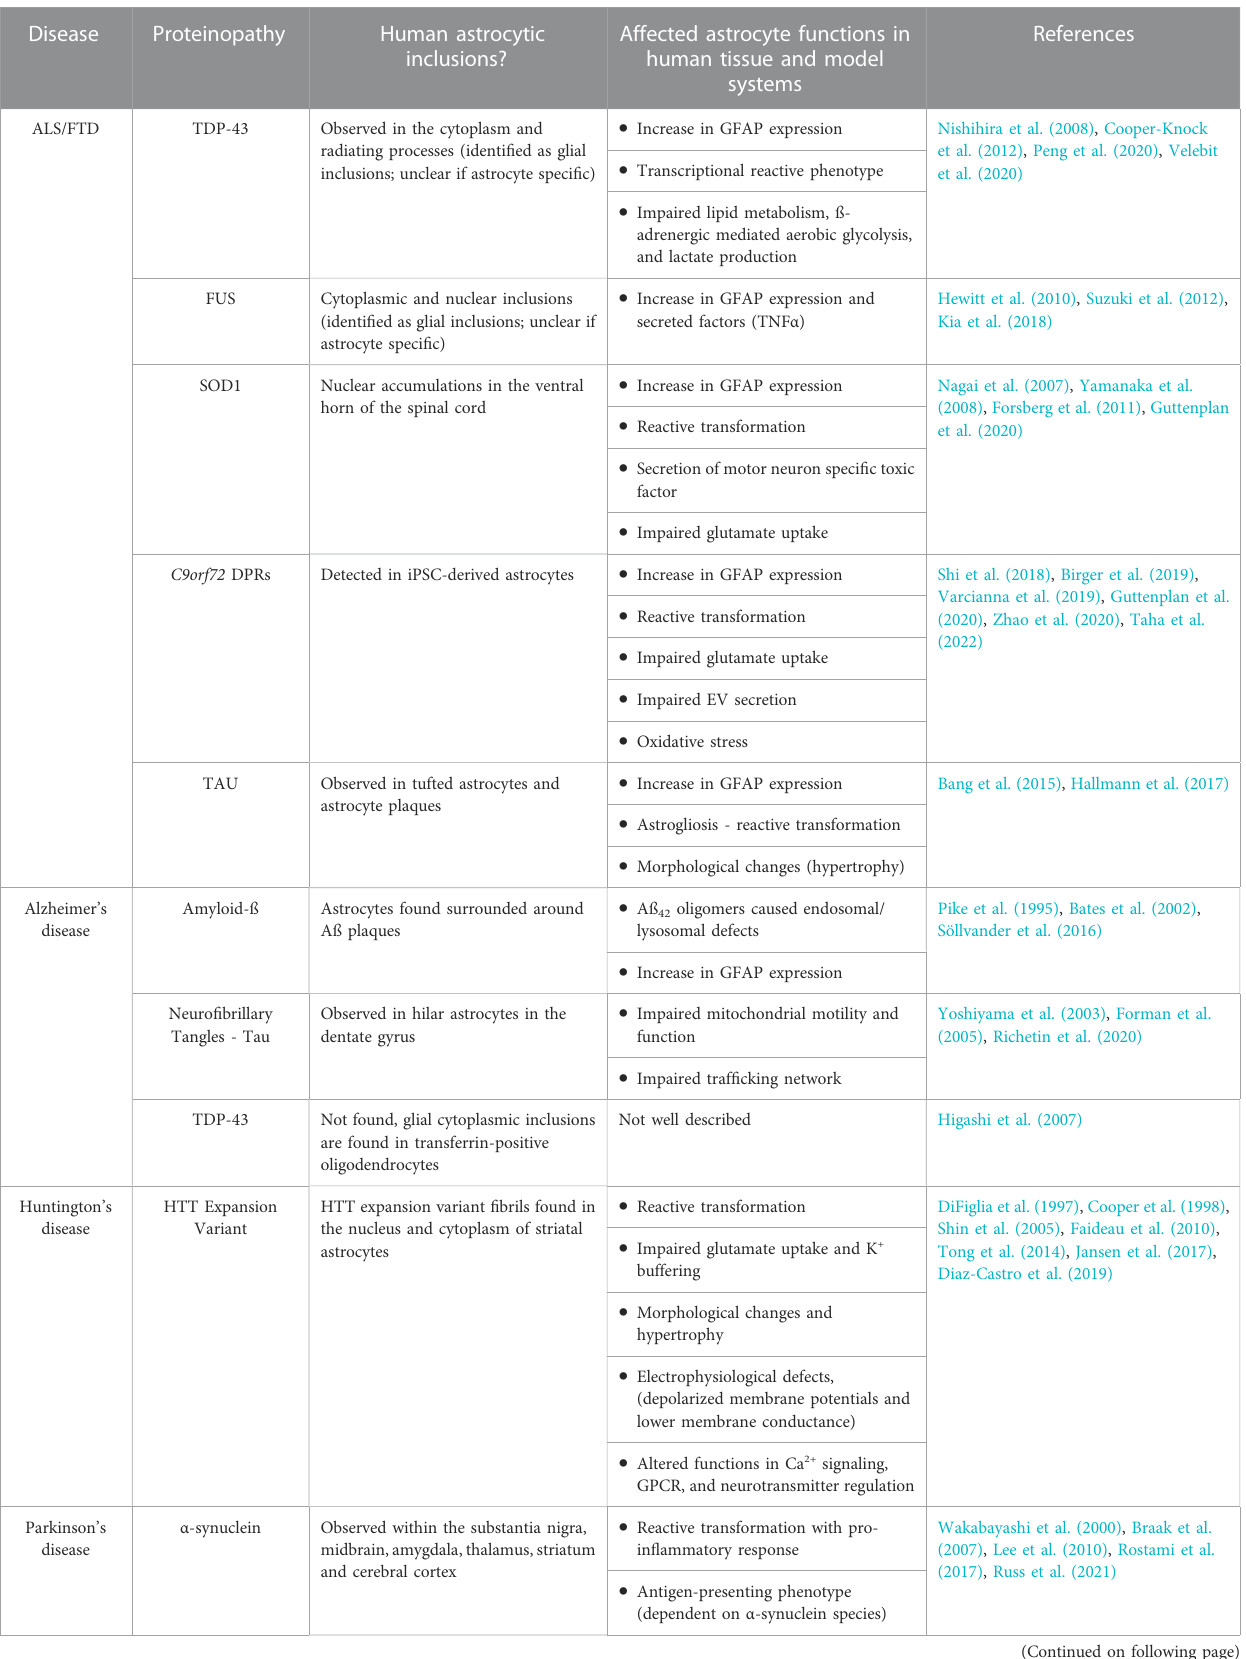
TABLE 1 Neurodegenerative disease pathologies affecting